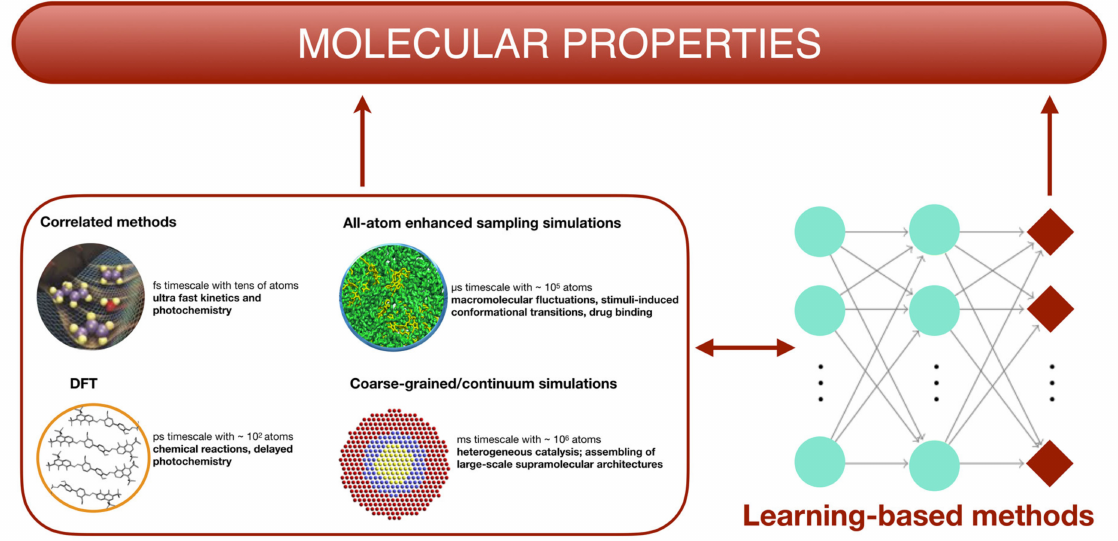
Figure 5. Timescale length governing the choice of the simulation technique used to predict a given chemical phenomenon. All the techniques can be in principle accelerated through learning methods, as machine or deep learning which includes neural networks, reported in the